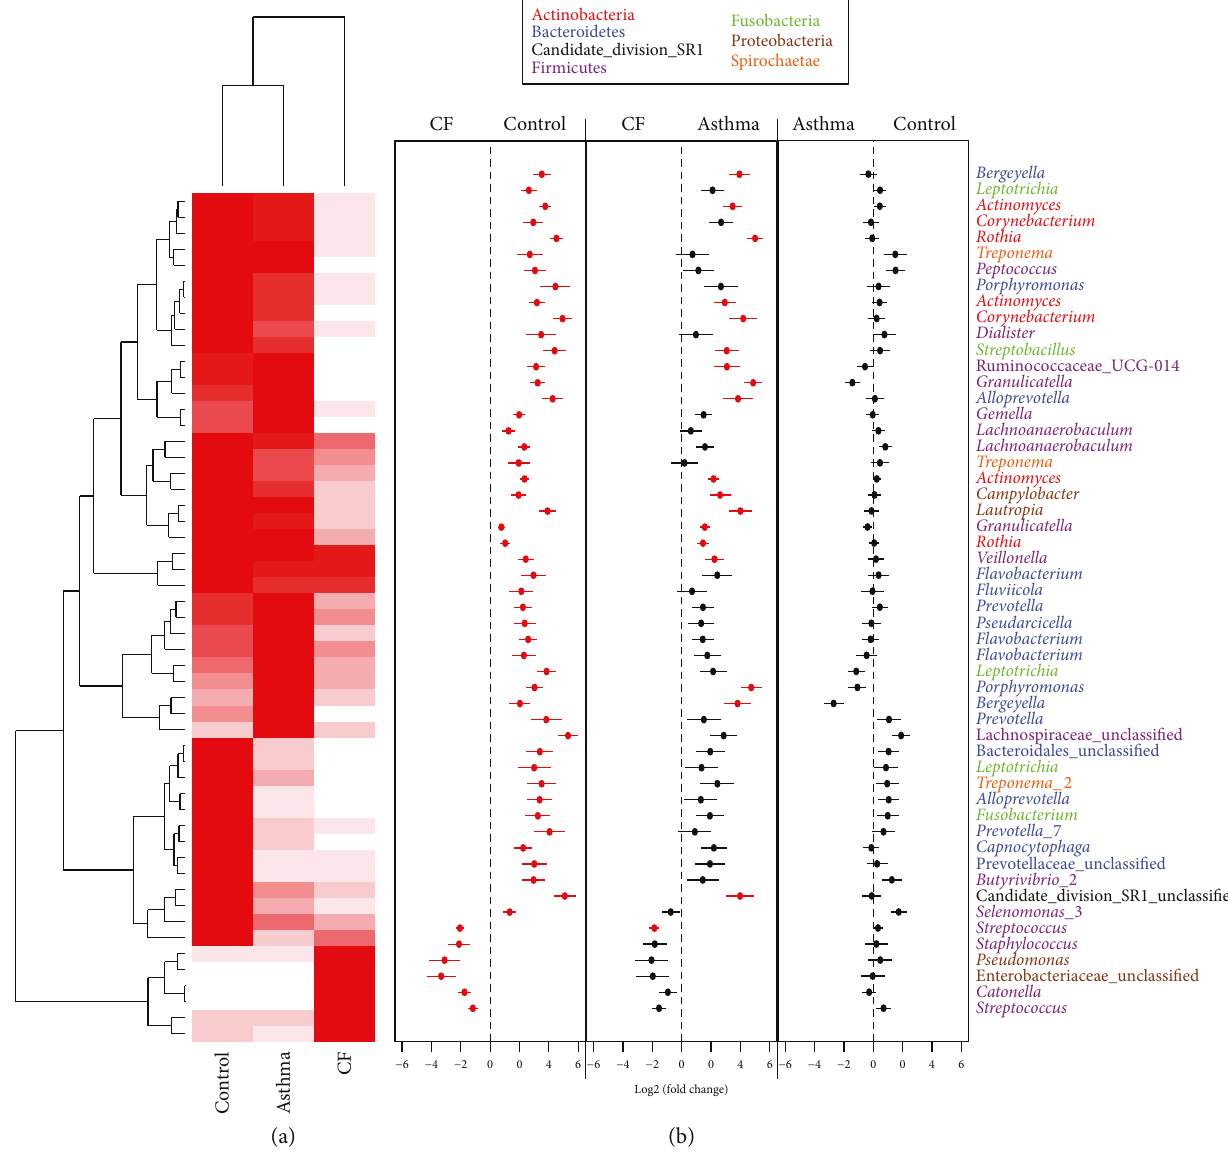
Figure 3: Di ff erences in OTU abundance between healthy children, children with asthma, and children with CF. Di ff erential abundance of each OTU was tested via a method based on the negative binomial distribution and is represented in a heatmap for the signi fi cantly di ff erentially abundant OTU. Mean abundance was normalized within each OTU to the maximal values (normalized value abundance )/maximum (relative abundance )). The color code is from white (minimal abundance: 0) to red (maximal OTU1 OTU1 abundance: 1). Fold changes between the groups and standard errors are displayed in (b). Red dots indicate signi fi cant di ff erences after correction for multiple testing. OTUs are named following their genus classi fi cation and colored following their phylum classi fi